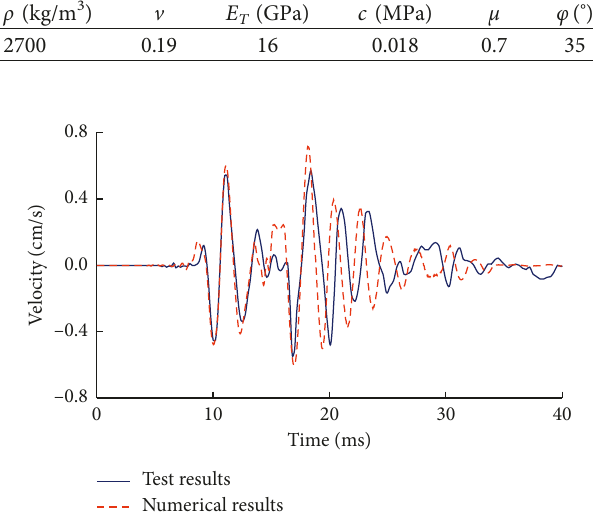
Figure 12: Comparisons of the velocities for test and numerical